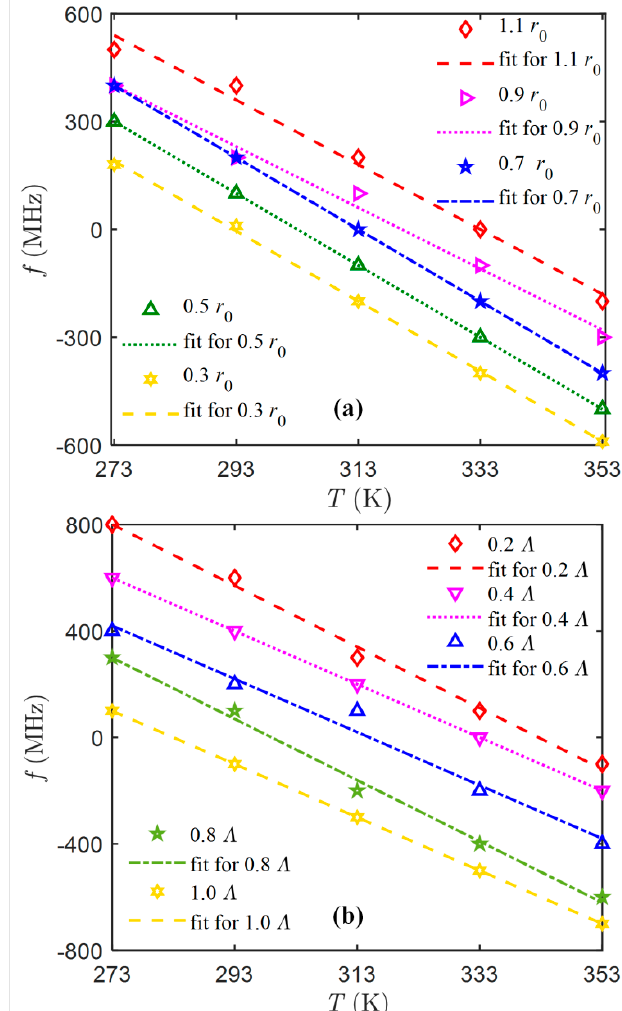
Figure 4. Structure optimization of the proposed THz thermal sensor. Frequency shifts for different defect radii, R ( a ), and different defect lengths, L ( b ).